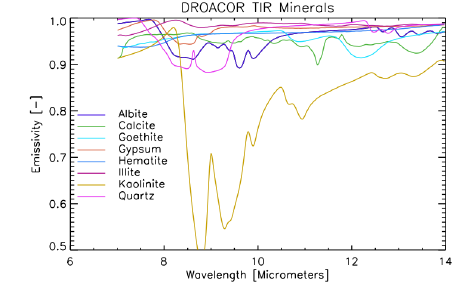
Figure 9. Emissivity spectra of minerals for standard inverse SAM